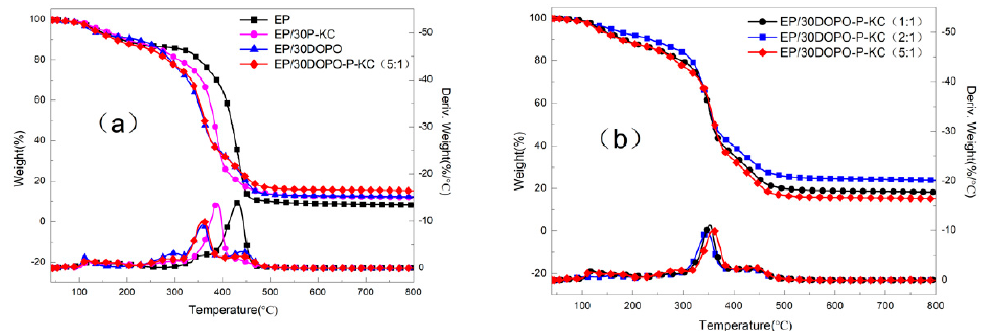
Figure 5. Thermogravimetric analysis and DTG curves of FR-EP under N 2 . ( a ) The top four lines belong to the left y-axis; the bottom four lines belong to the right y-axis; ( b ) the top three lines belong to the left y-axis; the bottom three lines belong to the right y-axis.